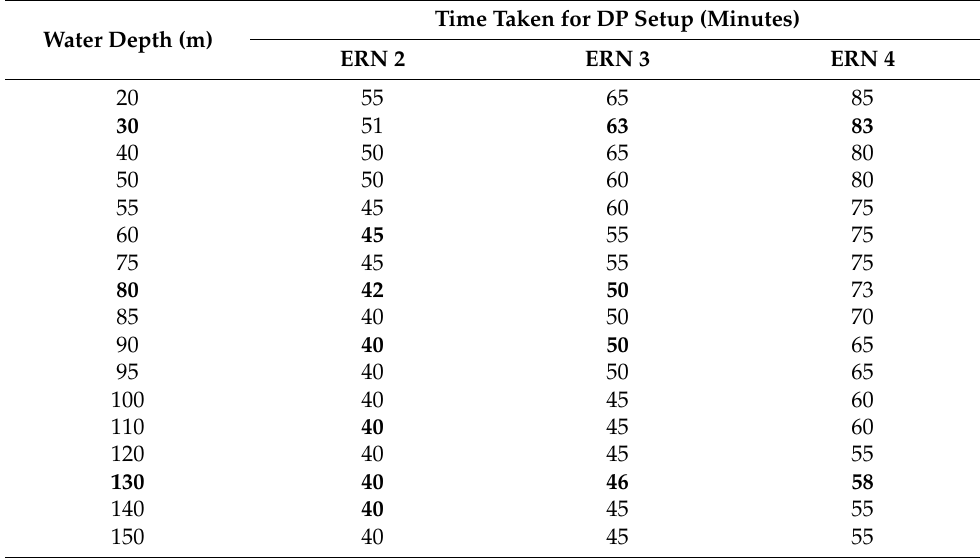
Table 5. Time taken for DP system positioning at various depth and ERN. Water Depth (m)